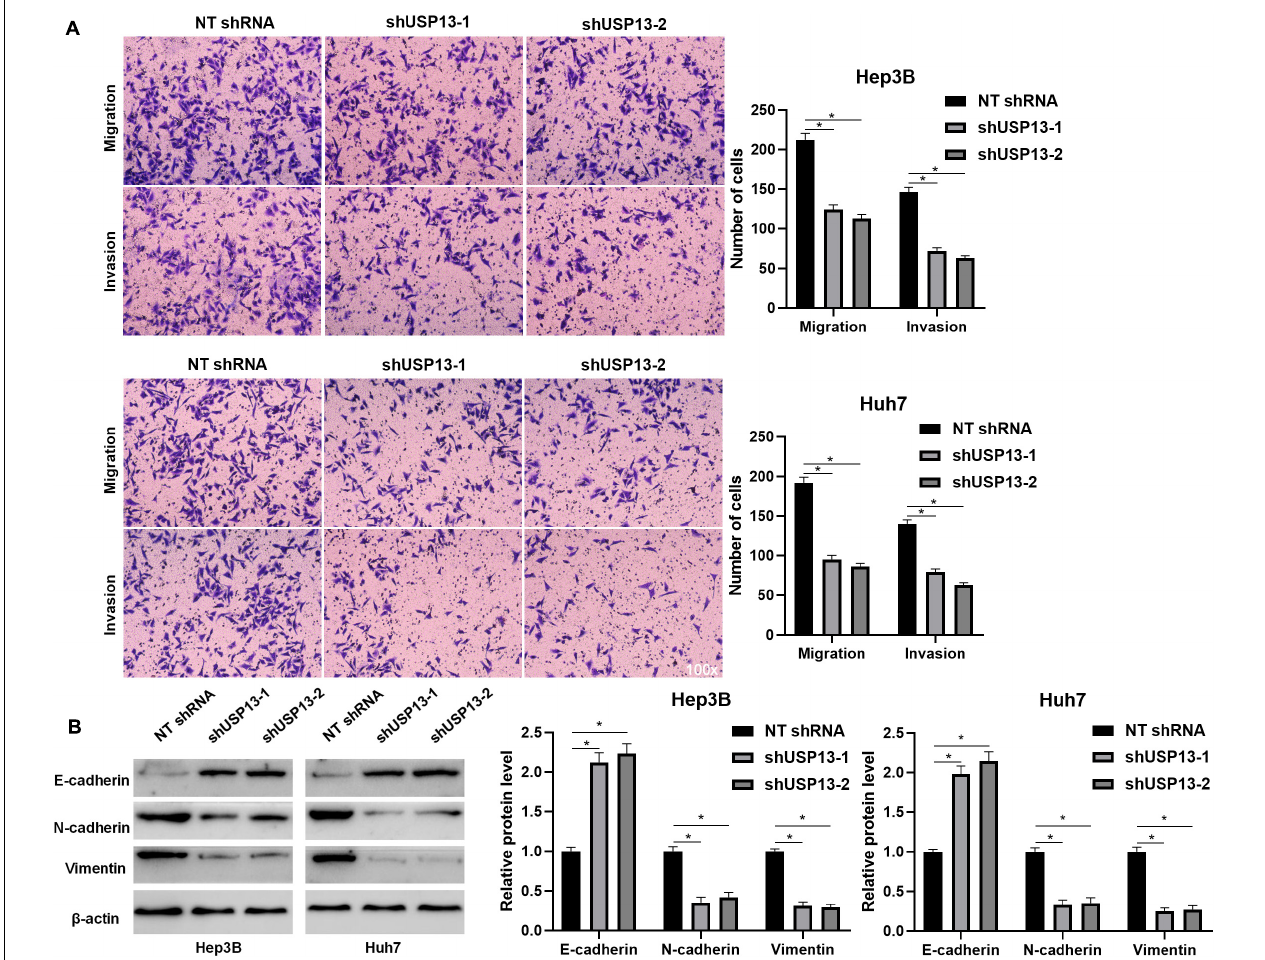
FIGURE 3 | USP13 depletion suppressed the EMT, migration, and invasion of HCC cells. (A) USP13 knockdown by two different shRNAs significantly reduced the number of migrated and invaded HCC cells. (B) Western blotting analysis indicated that USP13 knockdown increased E-cadherin expression and reduced N-cadherin and vimentin levels in HCC cells. * P <